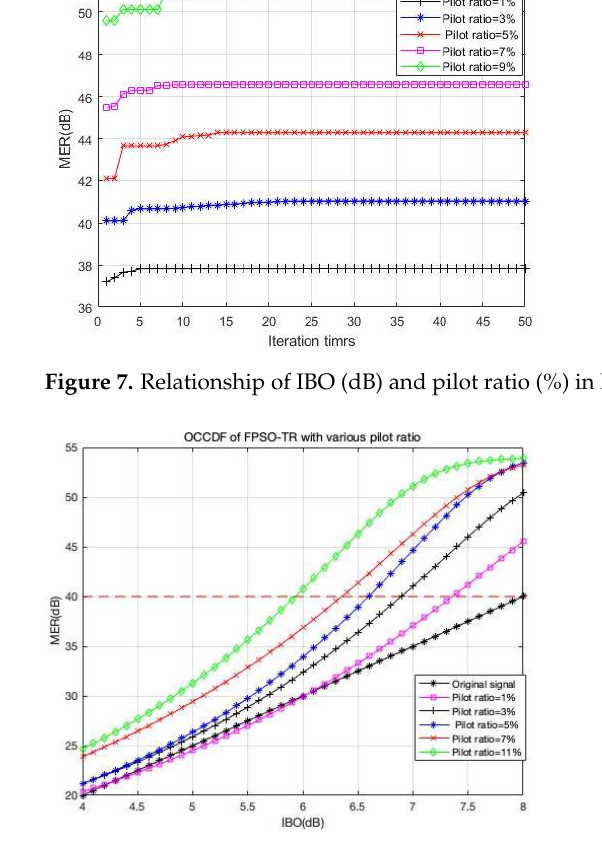
Figure 8. Novel maximizing HPA efficiency evaluation criteria.